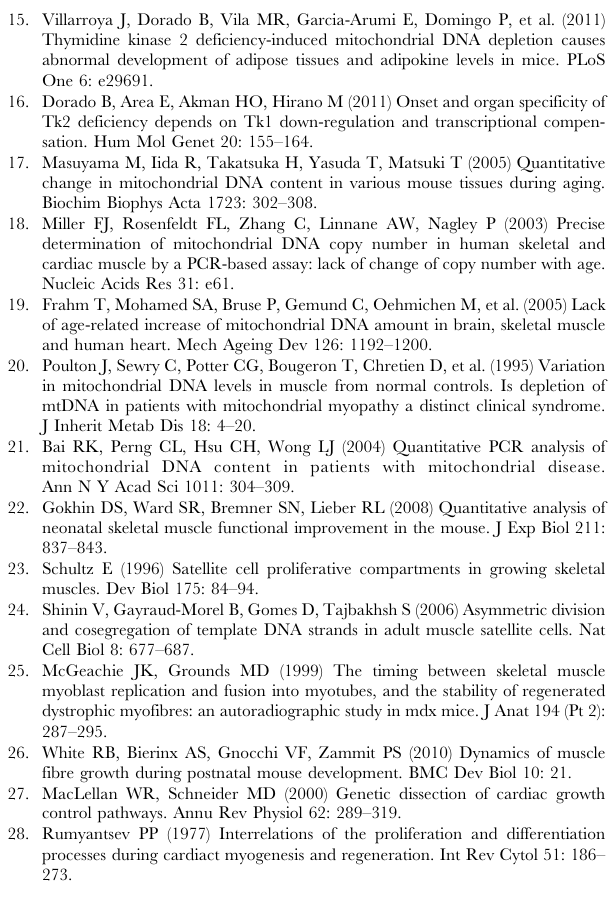
Figure S3 Tk2 2 / 2 mice skeletal muscle have several lipid droplets in its ultrastructure. Transmission electron microscopy images of skeletal muscle sections isolated from Tk2 knockout ( Tk2 2 / 2 ) 14 days-old mice. Lipid droplets are indicated with dashed arrows in the pictures. Figure S4 Desmin and Pax7 expression during Tk2 + / + and Tk2 2 / 2 primary myoblasts growth and differentia- tion. A ) Tk2 + / + and Tk2 2 / 2 primary myoblasts in F-10/DMEM- based primary myoblast growth medium (GM, 20% fetal bovine serum) were analysed by immunocytochemistry using anti-desmin and anti-Pax7 antibodies (Abcam). Nuclei have been stained with DAPI (Sigma). B ) Tk2 + / + and Tk2 2 / 2 cells after 6 days in differentiation medium (DM - DMEM with 5% horse serum). Immunocytochemistry was performed using anti-desmin and anti- Pax7 antibodies (Abcam). Nuclei have been stained with DAPI (Sigma). Figure S5 Flow cytometry analysis of Tk2 + / + and Tk2 2 / 2 myoblasts cell cycle, 16, 24 and 36 hours after cells have been plated. Data were obtained from 3 independent experiments ( n = 3) and were analysed using the ModFit LT software, in order to obtain the percentages of cells in G1, S and G2/M cell cycle phases. Figure S6 Gene expression variation of some stem cell and muscle progenitor cell marker genes in skeletal